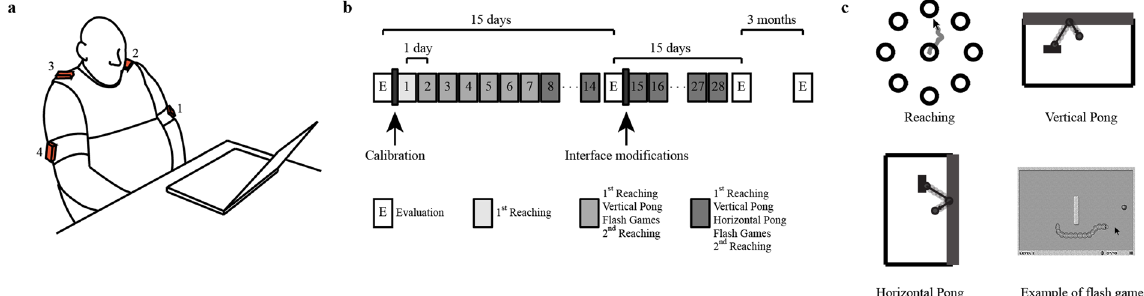
Figure 1. Experimental setup and training protocol. ( a ) Participants sat in front of a computer monitor wearing four inertial measurement units on arms and shoulders. ( b ) Study design. The participant started with an evaluation that was repeated every 15 days during the training period and after 3 months by the end of the training. The evaluations were performed in the laboratory set-up. The black rectangle indicates the times when the researcher operated the interface, thus calibration and interface modifications. Each practice session appears in the shades of grey. ( c ) Cartoon representing an example of all the tasks the subject is executing during the